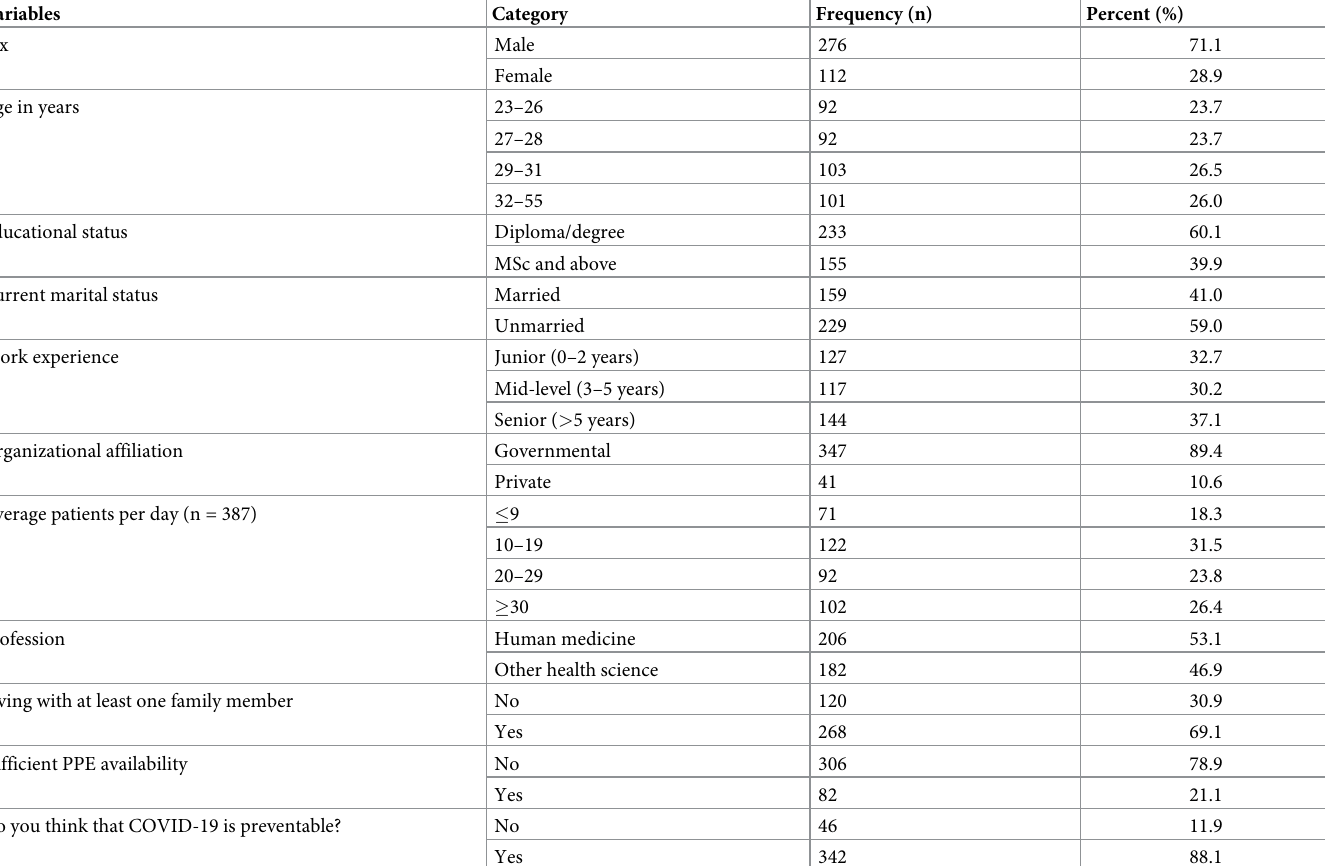
Table 1. Socio-demographic characteristics of health professionals screened for anxiety symptoms in Ethiopia during an early stage of COVID-19 pandemic (n =